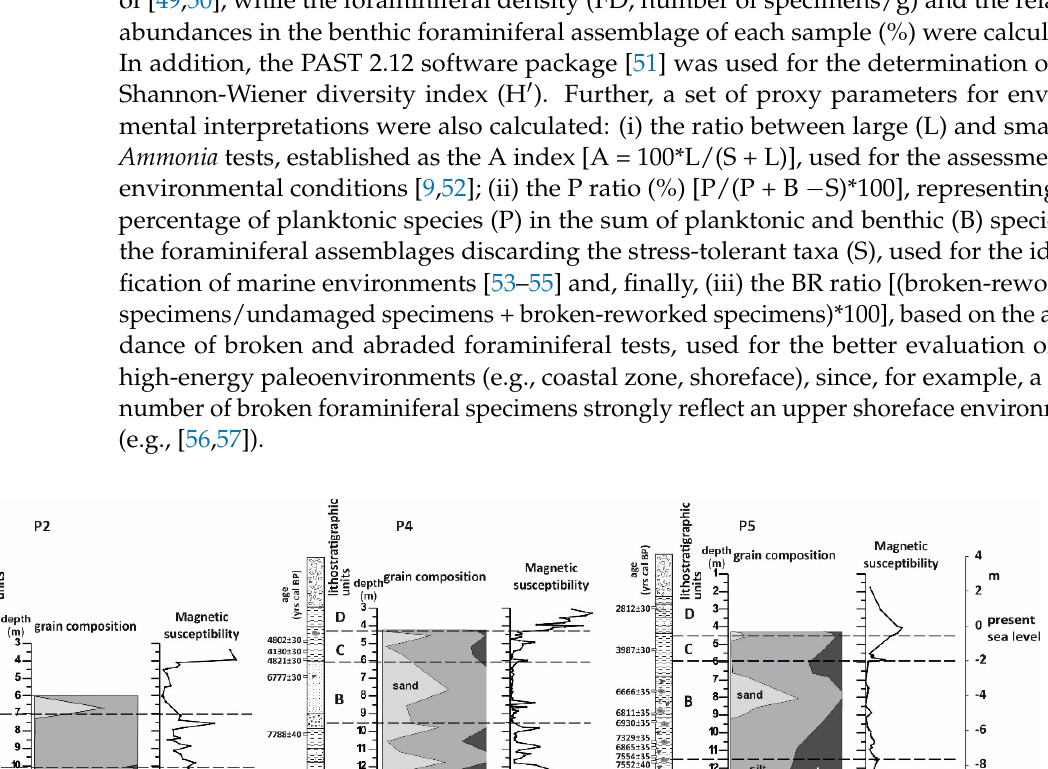
Figure 1. Map of the study area: ( a ) map showing the Saronikos Gulf; ( b ) Map of Greece where Saronikos Gulf is indicated; ( c ) Piraeus coastal plain showing the location of boreholes P2, P4, P5; ( d ) Elefsis bay showing the S2P coring location (source Hellenic Navy Hydrographic Service).